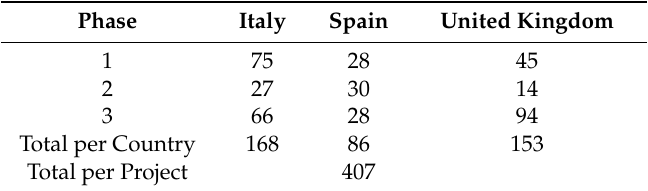
Table 1. Number of participants 1 in the focus groups in the three phases in each